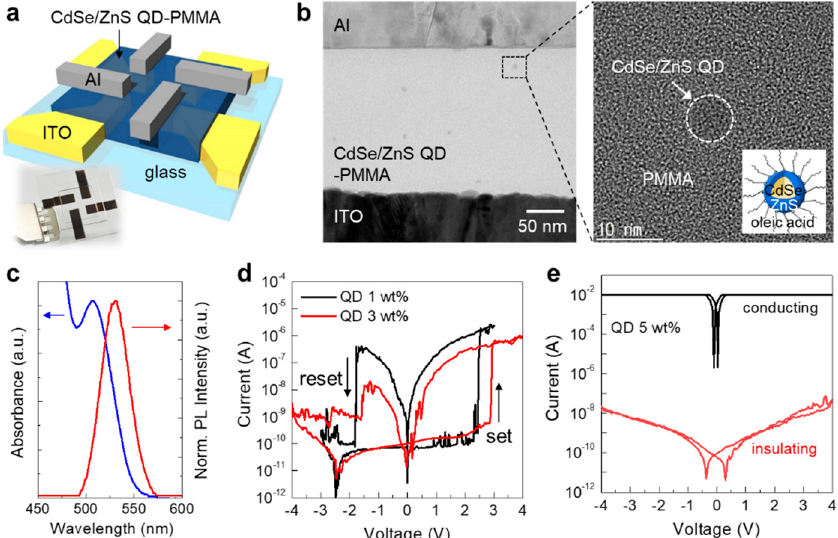
Figure 1. ( a ) Device structure and an optical image of solution-processed CdSe/ZnS QD-PMMA memristors. ( b ) Cross-sectional TEM images of the CdSe/ZnS QD-PMMA memristor. The inset shows the structure of CdSe/ZnS QDs with oleic acid as the ligand. ( c ) Light absorption and photoluminescence (PL) characteristics of CdSe/ZnS QDs. ( d ) Current-voltage (I-V) characteristics of CdSe/ZnS QD-PMMA memristors with QD concentrations of 1 wt% and 3 wt%, and ( e ) 5 wt%.